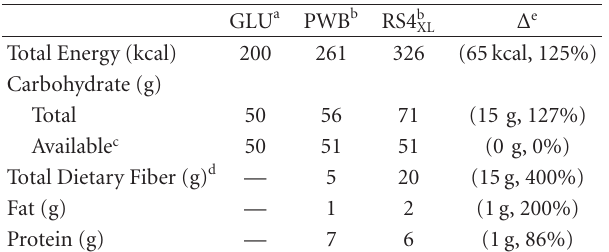
Table 2: Nutrient composition of each treatment per dose (GLU = 198mL; PWB = 65g; RS4 = 80